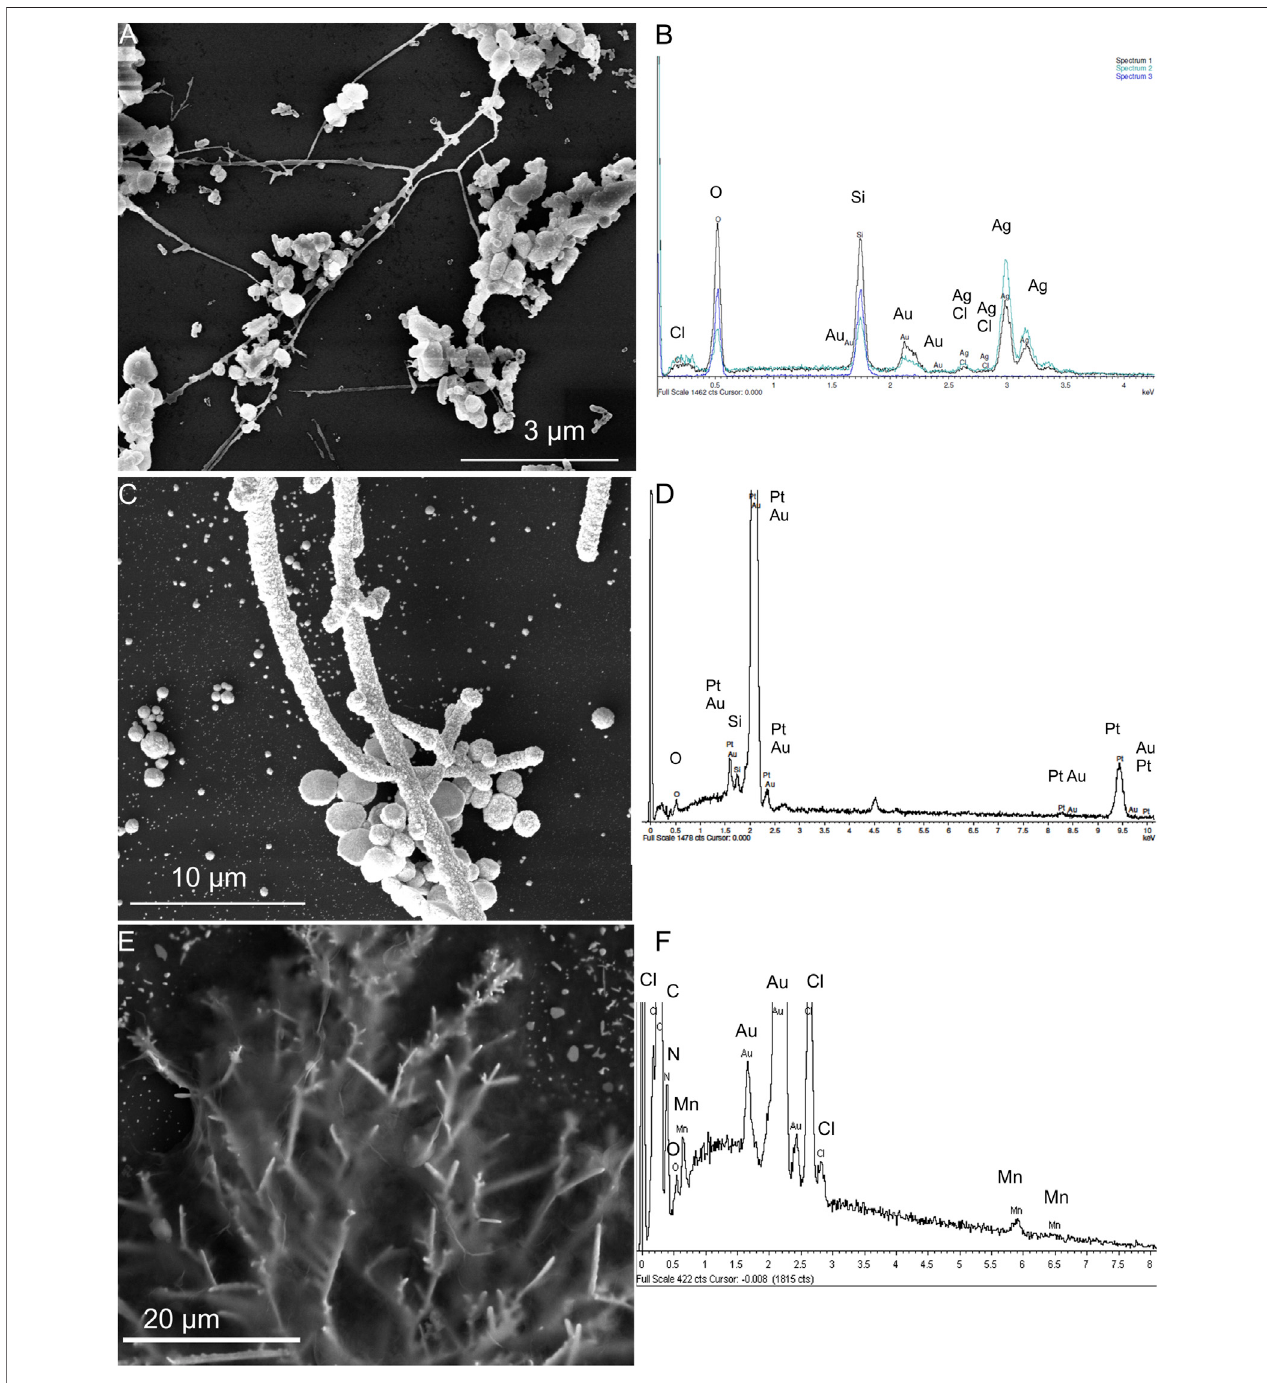
FIGURE 5 | SEM images and EDX spectra of the Ag/AgCl reference electrode (A,B) , Pt counter electrode (C,D) electrochemically deposited on the Au-ND electrodes, and ErGO/MnTMPyP working electrode (E,F) of the on-chip electrochemical system based on the Au-ND electrodes.